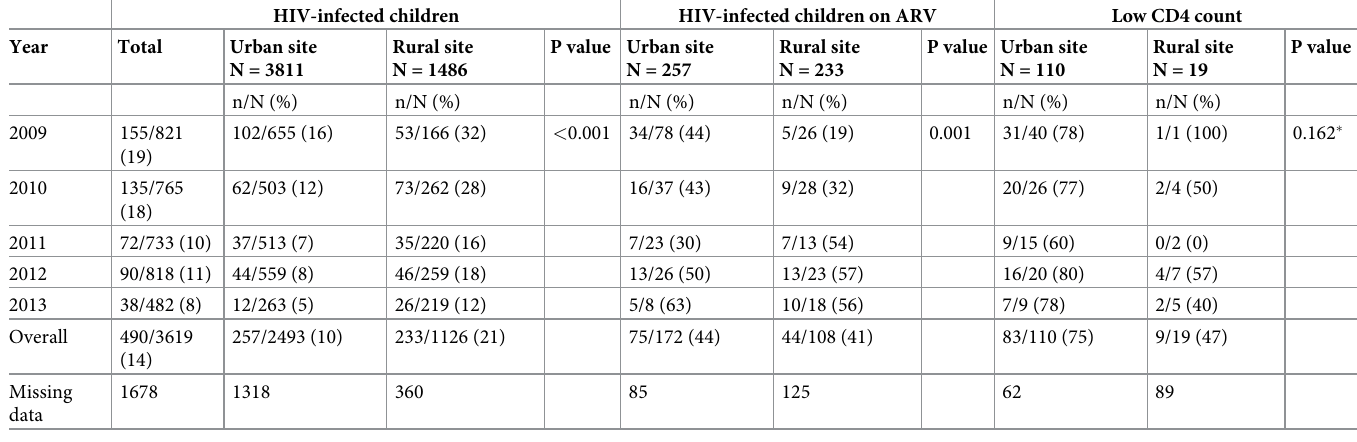
Table 3. Percentage of children that are HIV-infected, those receiving ARV and those having low CD4 count by year among children aged < 5 years hospitalized with SARI at urban and rural hospitals, South Africa